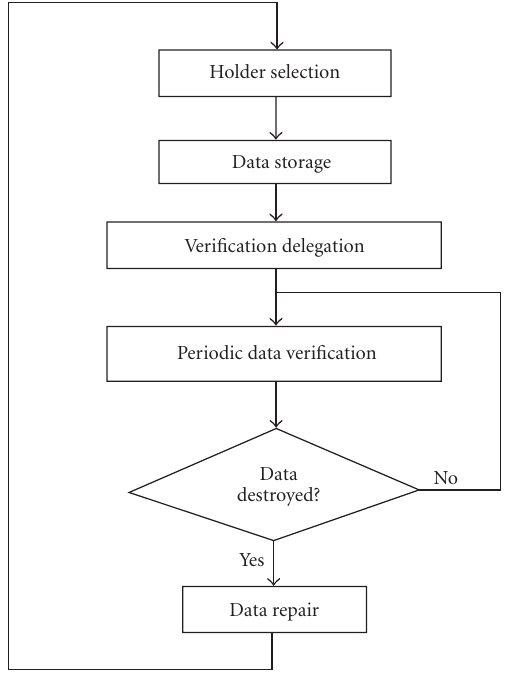
Figure 1: Data storage and maintenance